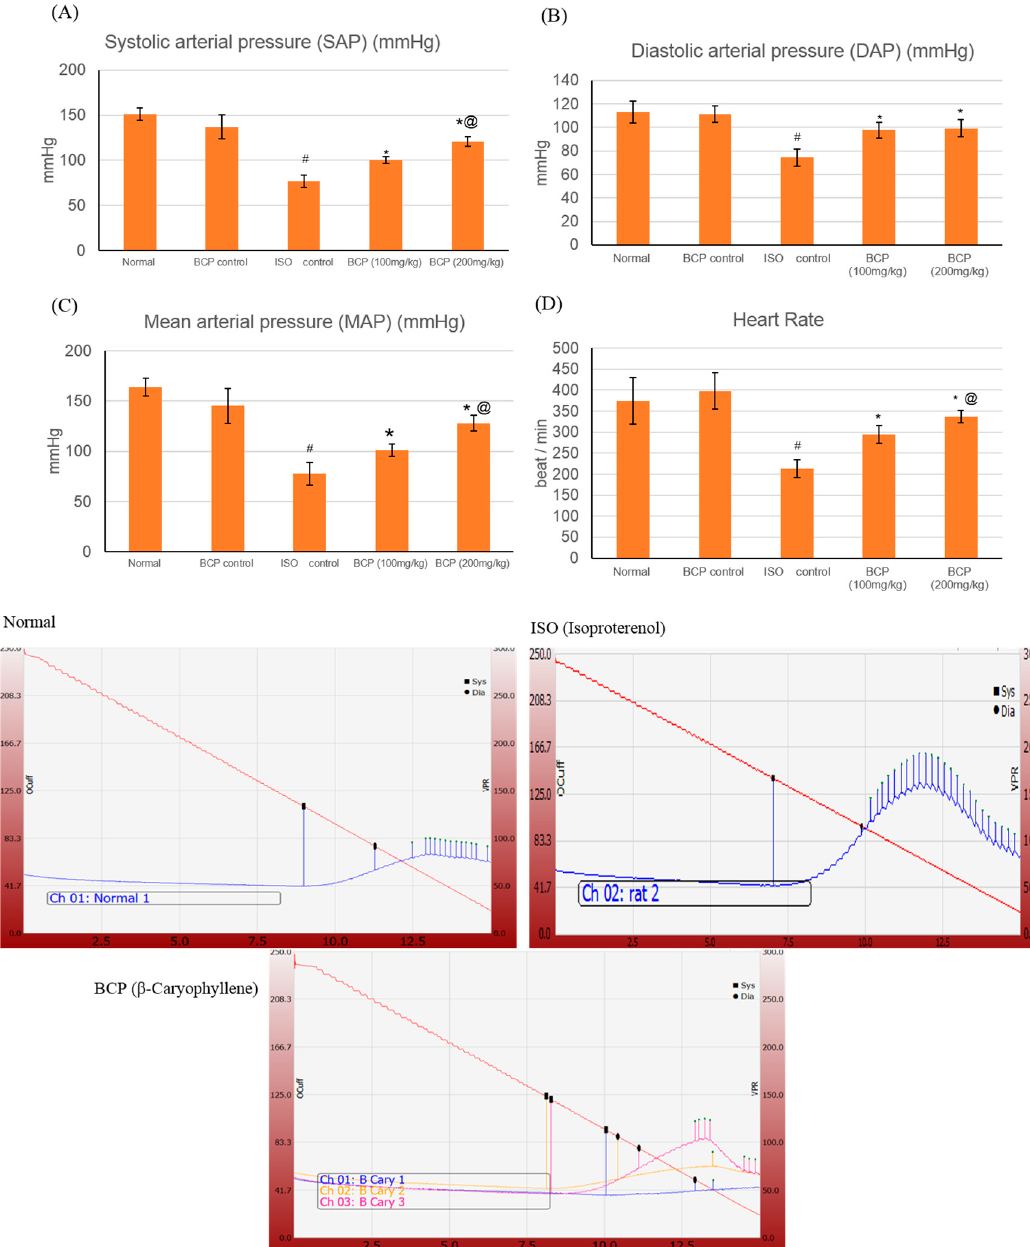
Figure 4. Upper section: effects of β -caryophyllene treatment (100, 200 mg/kg) for 21 days on Blood Pressure (BP) indices in ISO-induced myocardial infarction: ( A ) SAP; ( B ) DAP; ( C ) MAP; ( D ) HR. Lower section: shows representative computerized traces of the β -caryophyllene effects on BP. All values were expressed as mean ± SD ( n = 6). ISO: isoproterenol; BCP: β -Caryophyllene, SAP: systolic arterial pressure; DAP: diastolic arterial pressure; MAP: mean arterial pressure; and HR: heart rate. # indicates statistically significant from normal group, * indicates statistically significant from ISO group, @ indicates statistically significant from BCP (100 mg/kg) group ( p < 0.05) using one-way ANOVA followed by Tukey’s test as a post hoc analysis.